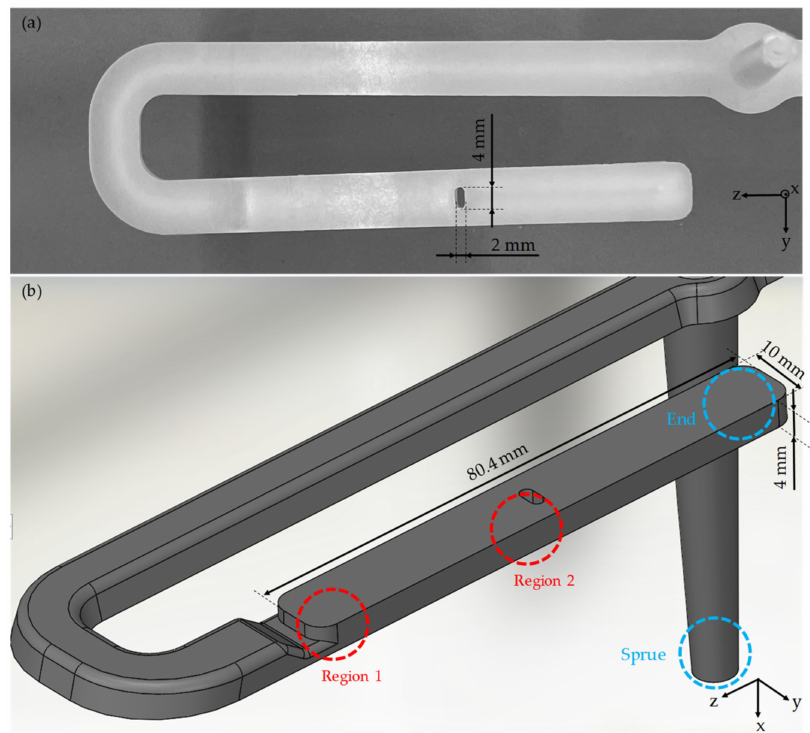
Figure 2. Photo ( a ) and CAD representation ( b ) of the manufactured test specimen with central notch and markings of the regions used for characterization and